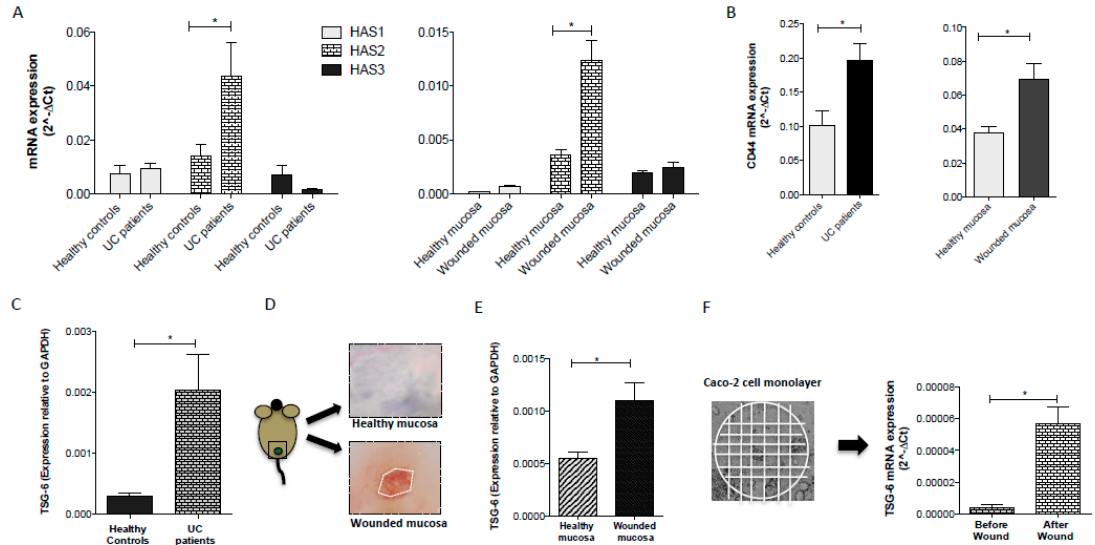
Figure 4. Inflammation and tissue damage induced synthesis of HA and the expression of CD44 and TSG-6. Gene expression of ( A ) Hyaluronan Synthase 1-3 (HAS1-3), ( B ) CD44, and ( C – E ) TSG-6 in UC patients vs. healthy controls (left panel) and in the mucosal wound of wild type mice (right panel). A mucosal wound was created by taking a discrete biopsy from the distal colon of mice. After 24 h, the wounded area was collected and analyzed. ( D ) Representative image of a wound site (white dotted line indicates wounded area) was acquired under a stereomicroscope at 4 × . ( F ) Confluent Caco-2 cells, plated in a 6-well plate, were scratched in several horizontal and vertical straight lines with a p200 pipette tip. After 24 h at 37 ◦ C, the cells were collected and processed for gene expression analysis of TSG-6. For all qRT-PCR results, data reflect the mean ± SEM from three independent experiments. The results were normalized to glyceraldehyde-3-phosphate dehydrogenase (GAPDH) mRNA. * P < 0.05 by one-way ANOVA. ( n = 14 UC patients and 11 healthy controls); ( n = 10 animals /